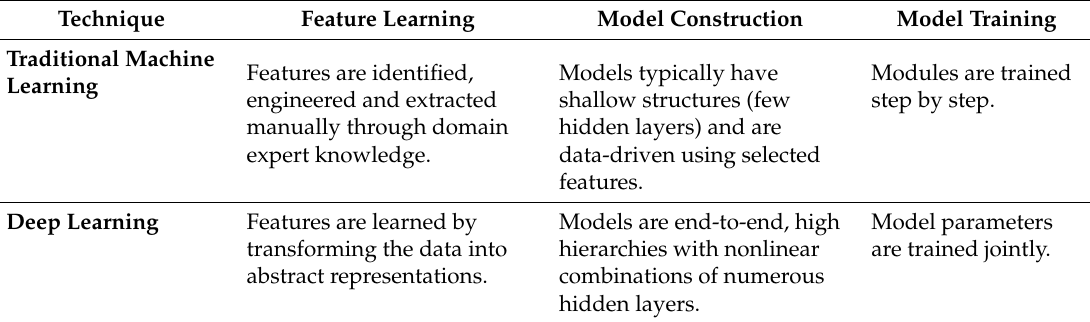
Table 1. Distinction between traditional machine learning and deep